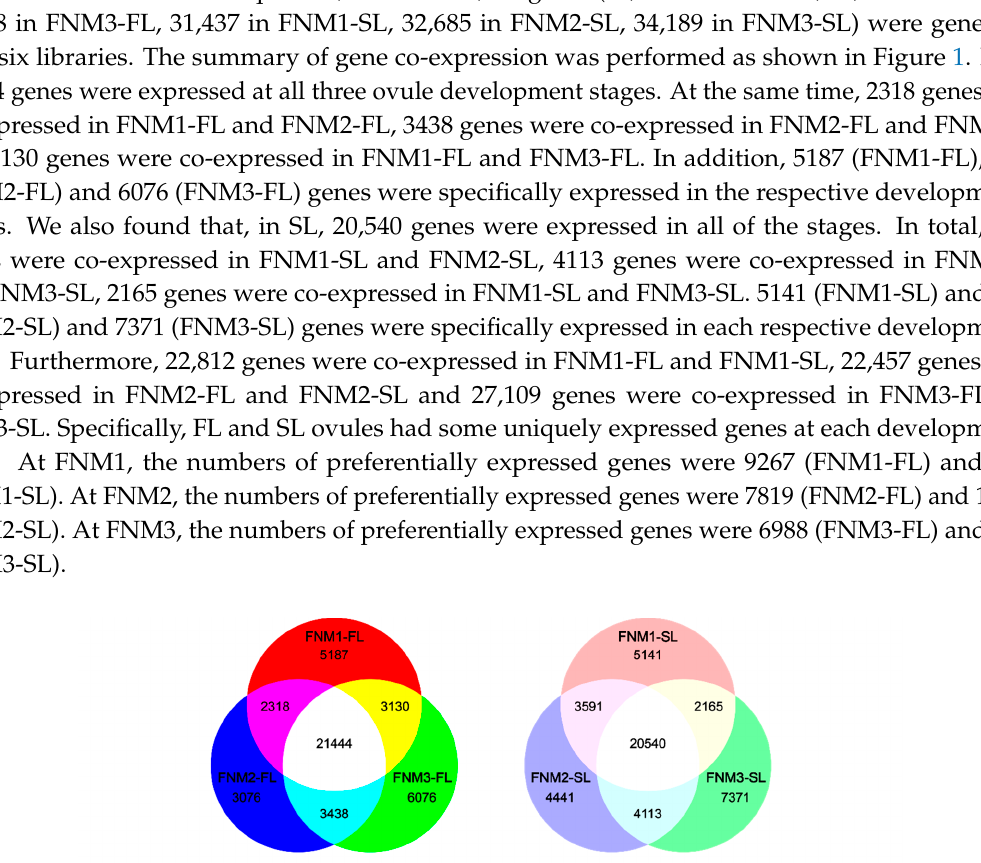
Table 2. Summary of the transcriptome assembly.